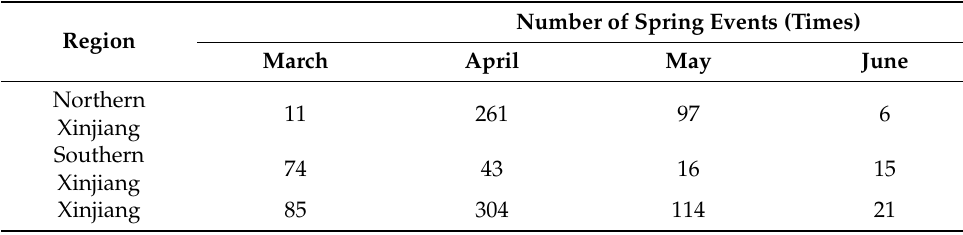
Table 4. Occurrence month of spring frost in